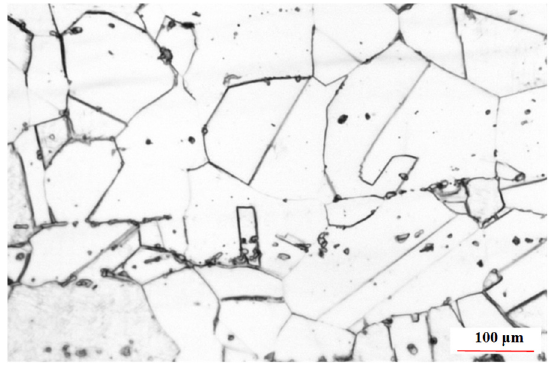
Figure 1. Base metal microstructure. Table 1. Chemical composition (wt %) of base material 316L and welding wire ER316L. Table 1. Chemical composition (wt %) of base material 316L and welding wire